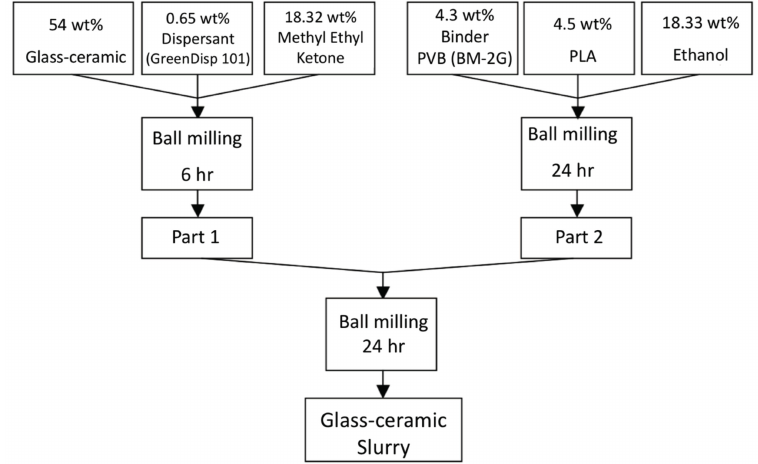
Figure 8. Preparation procedures for the LTCC pastes and content of the